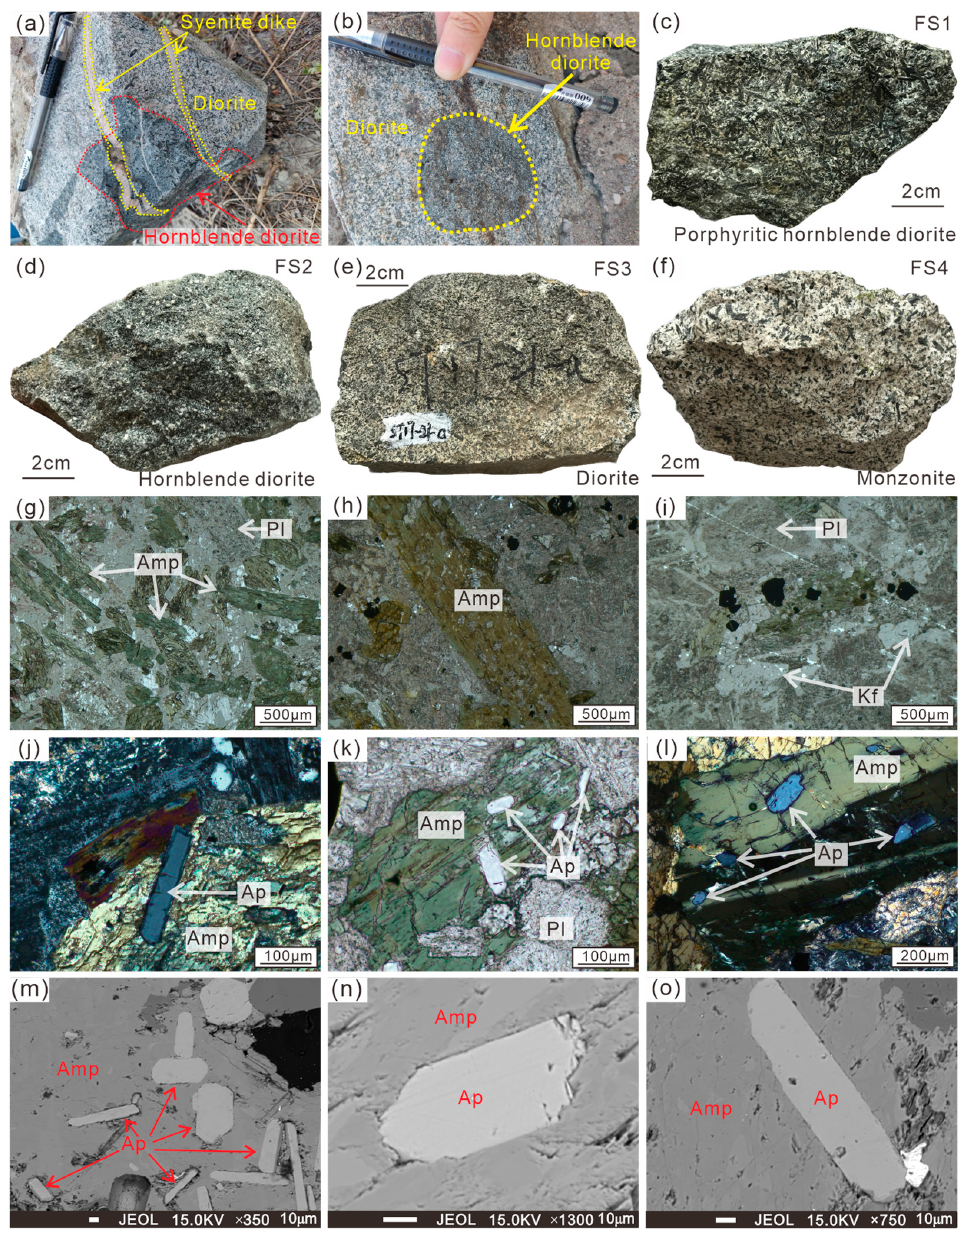
Figure 4. Sample features of the Fushan complex, ( a ) Hornblende diorite inclusions in diorite, diorite cut by syenite dikes; ( b ) Hornblende diorite occurs as enclaves enclosed in diorite; ( c ) Porphyritic hornblende diorite (FS1); ( d ) Hornblende diorite (FS2); ( e ) Diorite (FS3); ( f ) Monzonite (FS4); ( g ) Hornblende diorite (FS2), under plane-polarized light; ( h ) Diorite (FS3), under plane-polarized light; ( i ) Monzonite (FS4), under plane-polarized light; ( j – l ) Apatite coexisting with amphibole in some samples; ( m – o ) Apatite coexisting with amphibole in backscattering image. Mineral abbreviations: Amp = amphibole, Pl = plagioclase, Q tz = quar tz , Cpx = clinopyroxene, Kf = K-feldspar, Sph = sphene (titanite), Ap = apatite, Mag = magnetite. Four representative samples were collected from the Kuangshan complex, including